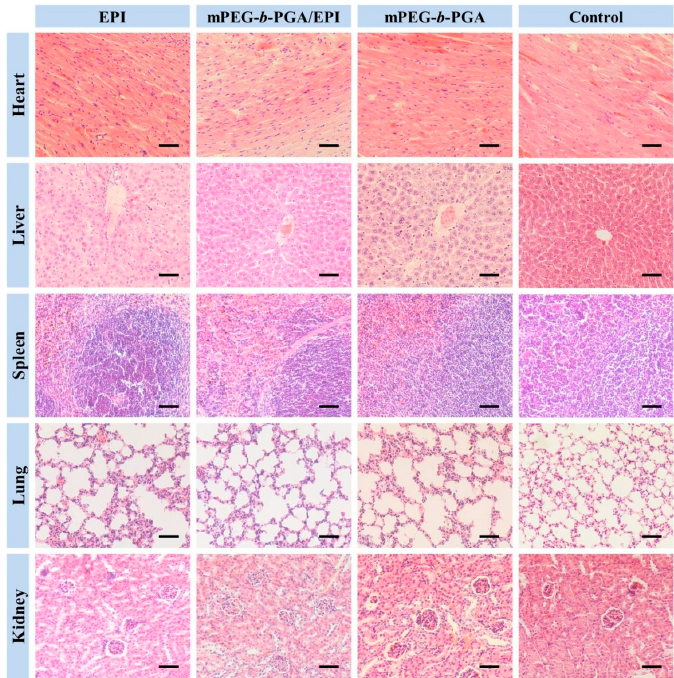
Figure 14. Histological analyses of main organs ( i.e. , heart, liver, spleen, lung, and kidney) from H22 HCC-xenografted mice after treatment of free EPI, mPEG- b -PGA/EPI, or mPEG- b -PGA with NS as control. Scale bar: 50.0 μ m.